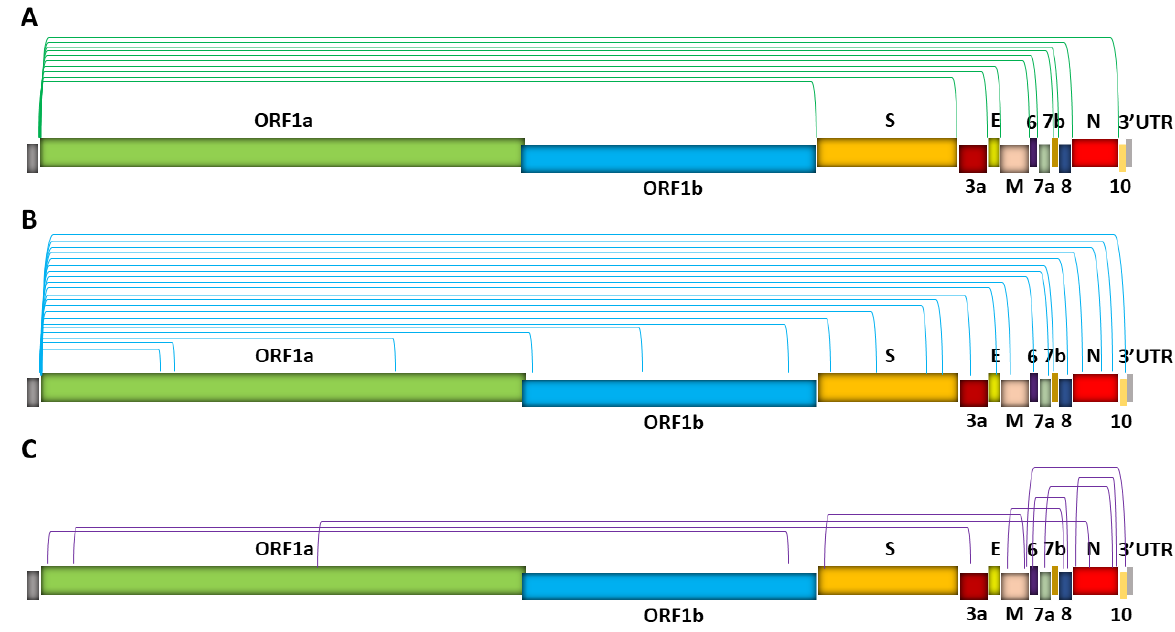
Figure 3. SARS-CoV-2 sgRNA recombination sites. Depicted are three types of fusion/junction sites. (Green, turquoise, or purple bracket lines represent the 5 ′ and 3 ′ locations of junctions.) ( A ) TRS-L- and TRS-B-dependent discontinuous transcription, which gives rise to canonical sgRNAs. Note that each canonical junction represents a group of subgenomes that have similar, yet distinct fusion junction sites upstream of a common first annotated gene downstream of the junction [6]. ( B ) TRS-L-dependent noncanonical fusions between TRS-L and unanticipated 3 ′ sites in the middle of ORFs or UTR (i.e., noncanonical 3 ′ sites) in the body. ( C ) TRS-L-independent fusion between sequences that share no similarity to the leader, resulting in long-distance fusions and smaller deletions mainly in the structural and accessory genes when the fusion occurs between proximal sites. Hundreds of noncanonical sgRNAs have been identified [5,6,12,20], and in ( B , C ), only several representative fusion patterns are illustrated. In addition, both in-frame and out-of-frame fusion products can be generated in ( B , C ), with out-of-frame noncanonical sgRNAs significantly outnumbering in-frame noncanonical sgRNAs (by ~60%) [12].